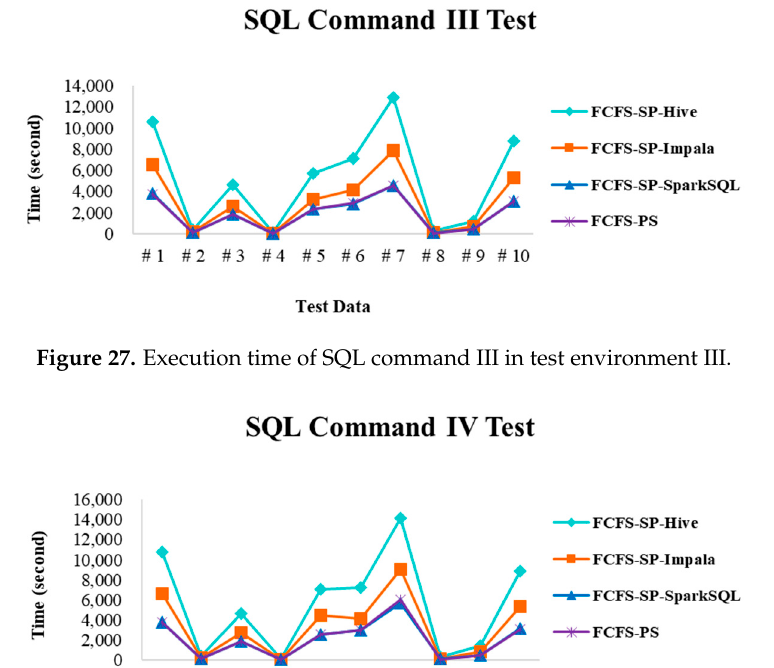
Figure 26. Execution time of SQL command II in test environment III.